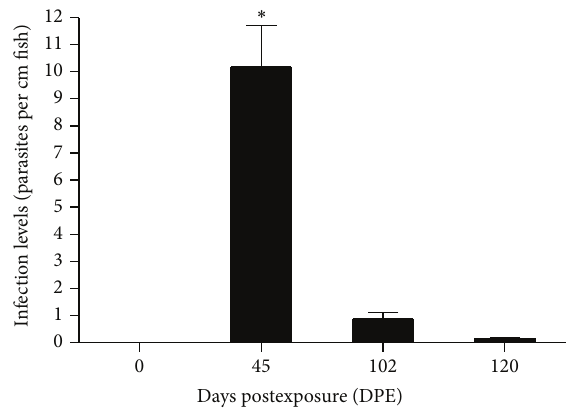
Figure 2: Effects of continuous exposure on infection levels as determined by number of parasites per fish length (cm) in tilapia at 45, 102, and 120 days postexposure (DPE) and uninfected fish (0 DPE). Vertical bars indicate mean ± SEM. ∗ Significantly different at 𝑃 < 0.05 , by one-way ANOVA and Student’s 𝑡 -test.